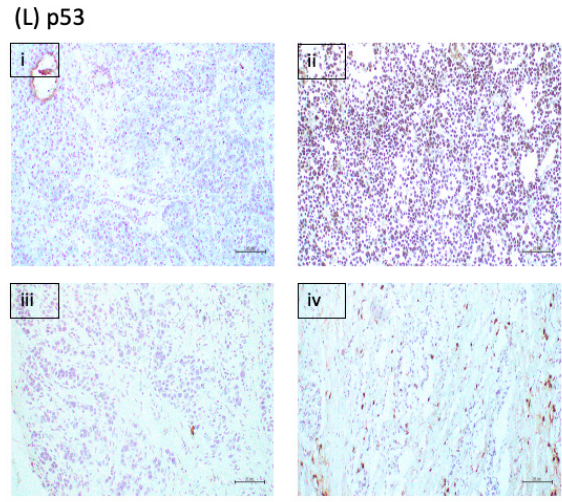
Figure 3. IHC images for selected markers ( A ) CgA, ( B ) synaptophysin, ( C ) CD56, ( D ) Ki-67, ( E ) DAXX, ( F ) CD44, ( G ) CD31, ( H ) vimentin, ( I ) laminin, ( J ) PDX1, ( K ) CK7, ( L ) p53 at 200 × magnifi- cation. For each marker, the four images represent (i) non-tumour pancreatic tissue, (ii) G1, (iii) G2 and (iv) G3 tumour tissue. Scale: 20 μ m.